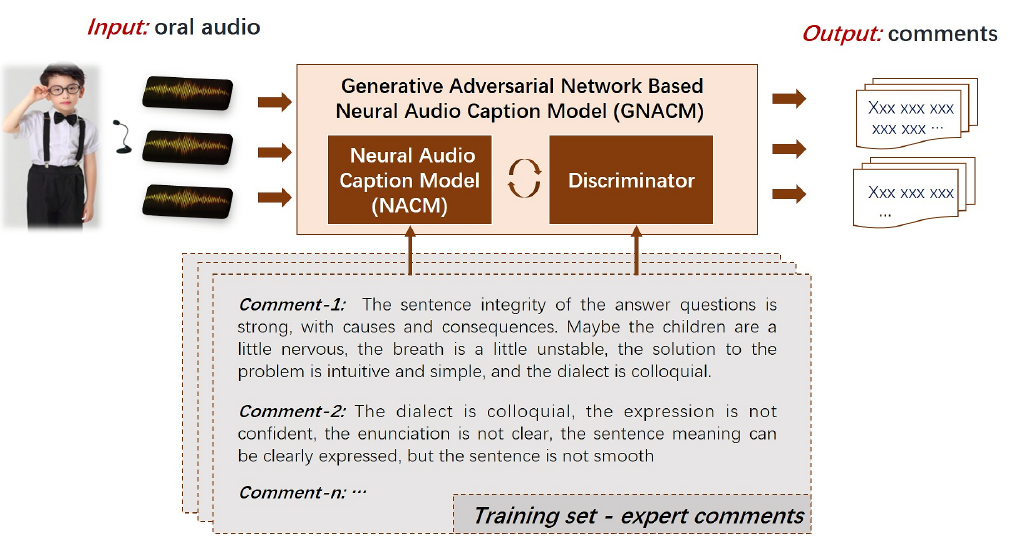
Figure 1. The overview of the proposed approach for the oral